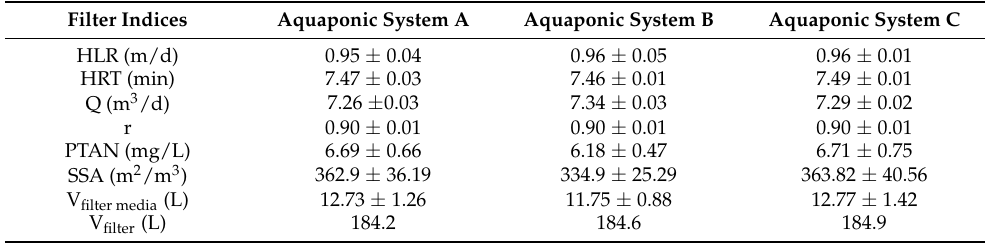
Table 4. Functional characteristics of the filters in the aquaponic systems over the 45-day period.